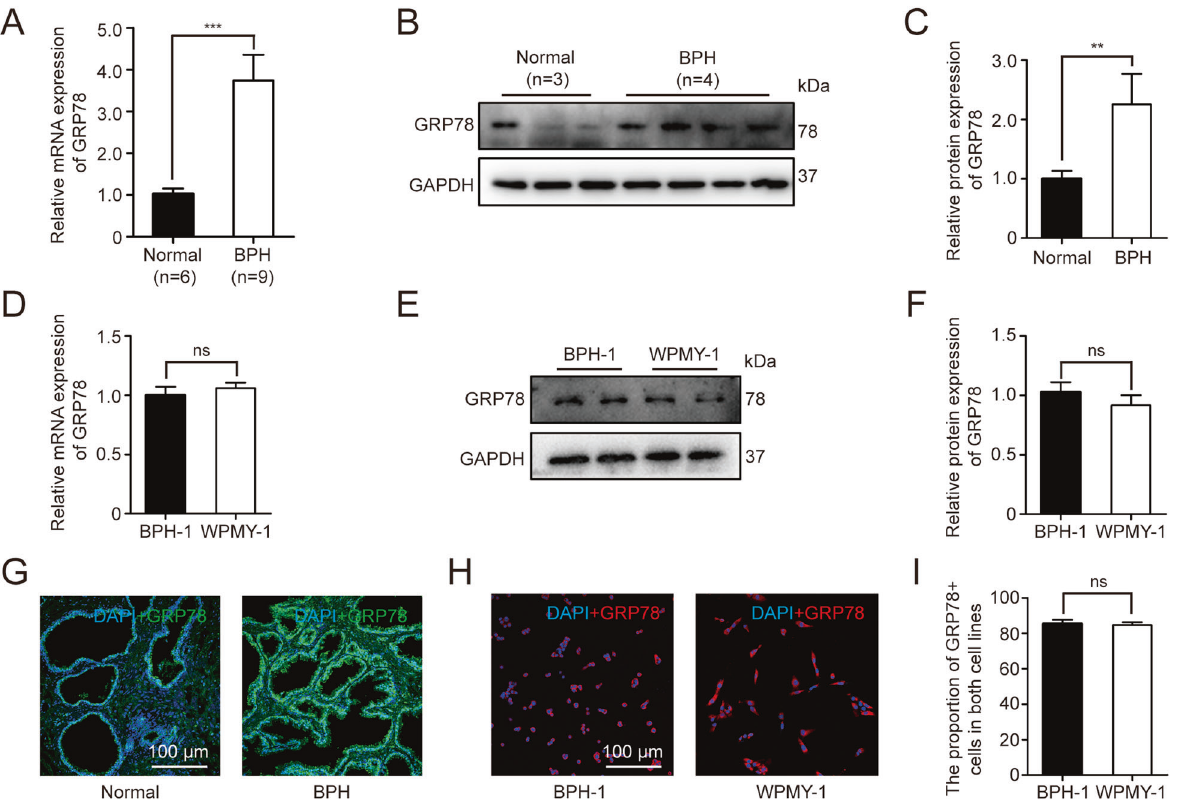
Fig. 1 GRP78 is upregulated in hyperplasic prostate tissues and localized at stromal and epithelial regions of human prostate tissues. A The expression of GRP78 in BPH tissues vs normal tissues at the mRNA levels determined by qPCR. B , C Western blotting analysis and relative densitometric quanti fi cation of GRP78 in prostate tissues. D The mRNA expression of GRP78 in BPH-1 cells vs WPMY-1 cells. E , F The protein expression and relative densitometric quanti fi cation of GRP78 in two cell lines. G Immuno fl uorescence staining for GRP78 in the hyperplastic prostate and normal prostate. DAPI (blue) indicates the nucleus staining. Cy3-immuno fl uorescence (green) represents GRP78 protein staining. H , I Immuno fl uorescence staining for GRP78 in prostate cells. DAPI (blue) indicates the nucleus staining. Cy3-immuno fl uorescence (red) represents GRP78 protein staining. The proportion of GRP78 + cells was quanti fi ed. The scale bars are 100 μ m. GAPDH is used as loading control. ns: p > 0.05; ** p < 0.01; *** p <